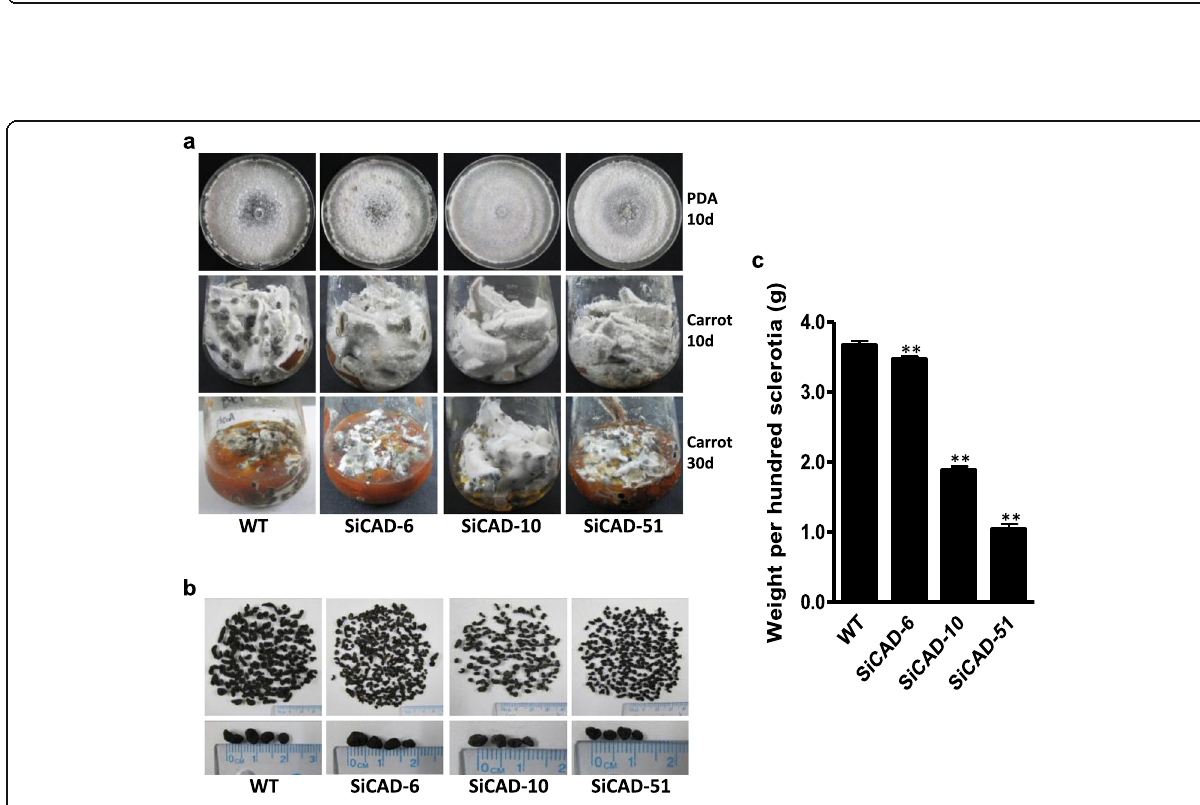
Fig. 2 Ss-CAD -silenced transformants showing abnormal sclerotial development. a Phenotypes of the wild-type strain and Ss-CAD gene-silenced transformants were cultured on PDA and carrots. Photographs were taken 10 and 30 days post-inoculation (dpi). b Relative sizes of sclerotia formed by Ss-CAD -silenced transformants and the wild-type strain on carrot rods. c Relative weights of sclerotia formed by Ss-CAD -silenced transformants and the wild-type strain on carrot rods. Sclerotia were produced on autoclaved carrot rods incubated in 250-mL flasks at 20 °C for 30 d. For each strain, 100 randomly selected sclerotia were photographed and weighed. Three independent replicates were performed for all experiments. Values are means ± S.E. ** P < 0.01; one-way